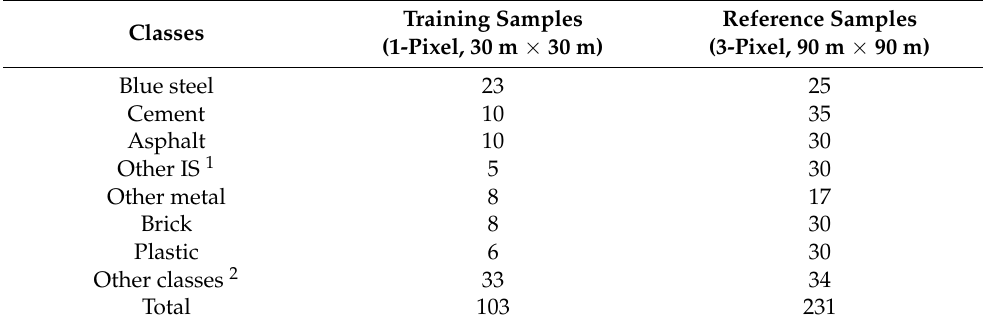
Table 1. Numbers of samples for each